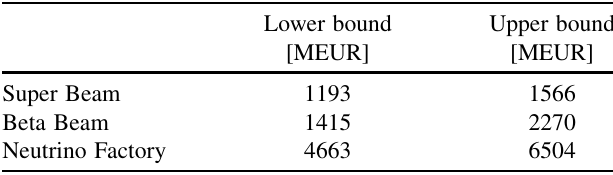
TABLE I. Total cost of the three accelerator